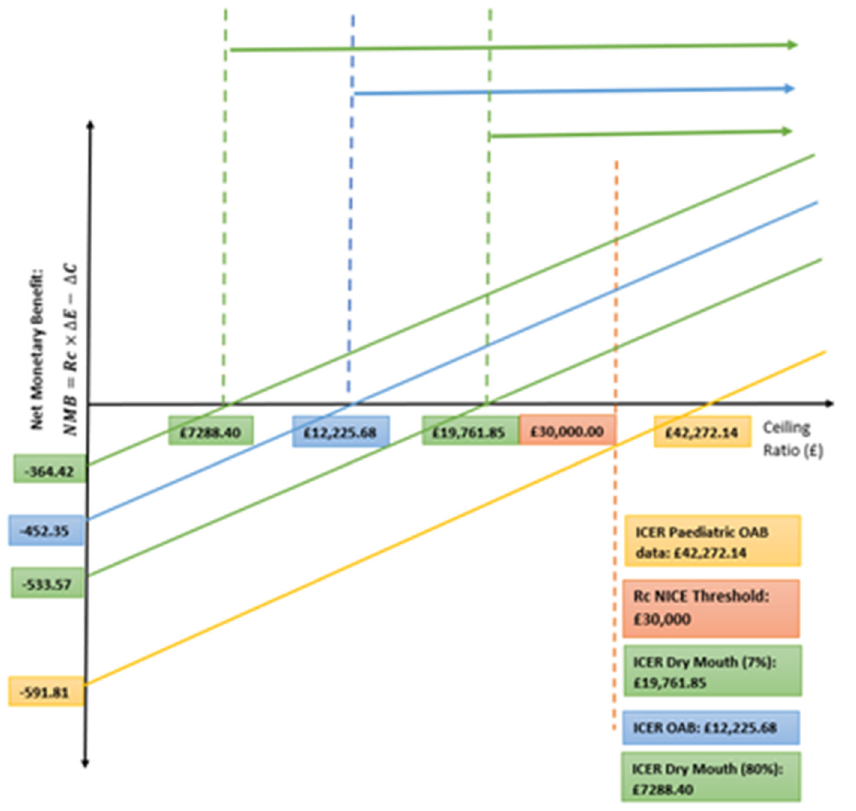
Figure 4. Net Monetary benefit.